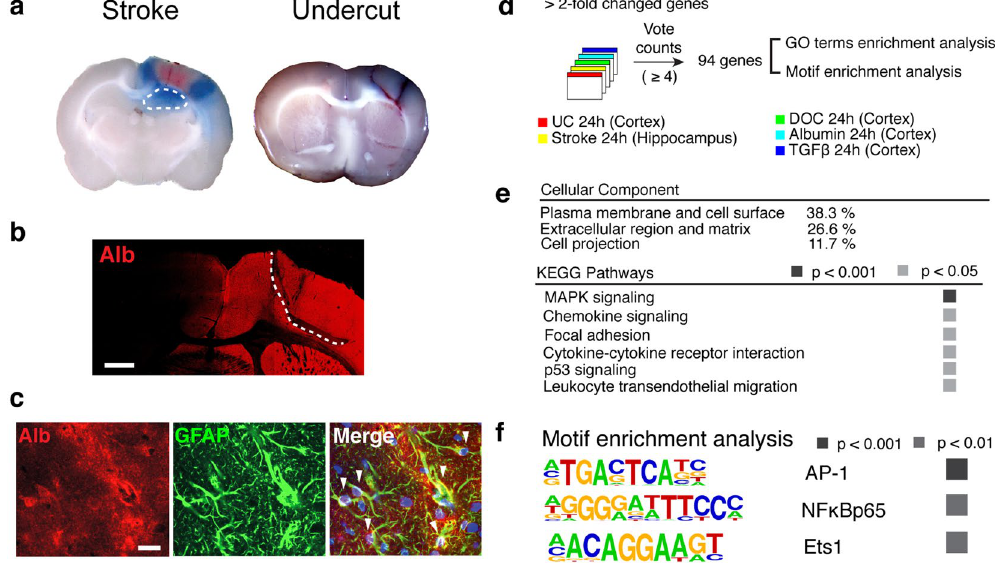
Figure 1. Comparative analysis revealed a common transcriptional signature in hyperexcitable regions following different insults. ( a ) Evans blue extravasation indicating BBB disruption in the peri-infarct hippocampus (outlined with white dotted line) and around the partially-isolated cortical regions 12 hours after stroke (left) and the undercut operation (right). ( b ) Representative micrograph of a rat brain slice immunostained for albumin (Alb) at 24 hours following the undercut (UC) operation (indicated by white dotted line). Scale bar = 1mm. ( c ) Representative confocal images of the UC cortex showing co-localization (white arrowheads) of albumin with GFAP ( + ) astrocytes. Nuclear staining with DAPI (blue) in the merged image. Scale bar = 20 μ m. ( d ) A vote counting method for five independent microarray datasets from the undercut cortex (UC), peri-infarct hippocampus (Stroke), BBB-disrupted cortex treated with sodium deoxycholate (DOC), and cortices exposed to albumin (Alb) or TGF β 1 (TGF β ). ( e ) The gene ontology (GO) term enrichment analysis in the common transcriptional profile. ( f ) Using HOMER software, motifs including AP-1, NF κ B, and ETS1 were found significantly enriched in the promoter proximal region, ± 500 base pairs of the commonly upregulated genes across